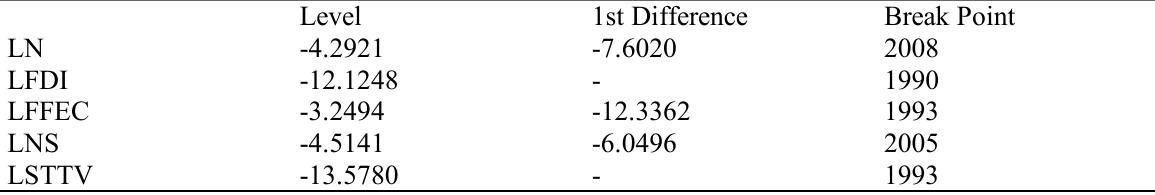
Table 4. Short-term dynamic